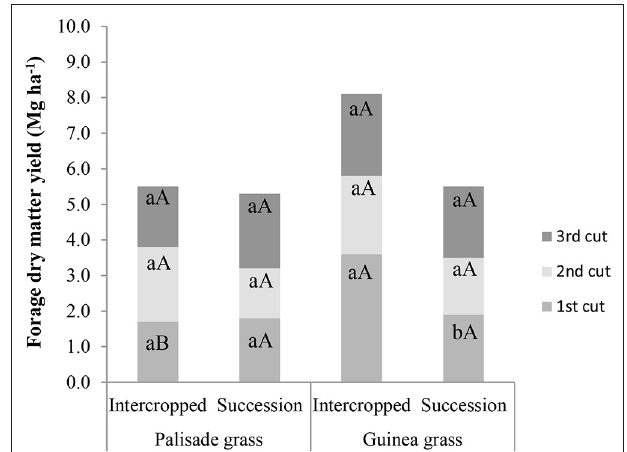
FIGURE 1 | Forage dry matter production (FDMP) of three cuts as a function of sowing times and forage species (average of two growing seasons). Values followed by the same lowercase letter (comparison of sowing times for the same forage specie) or the same uppercase letter (comparison of forage species for the same sowing time) for each cut are not significantly different at P < 0.05 according to the LSD test.